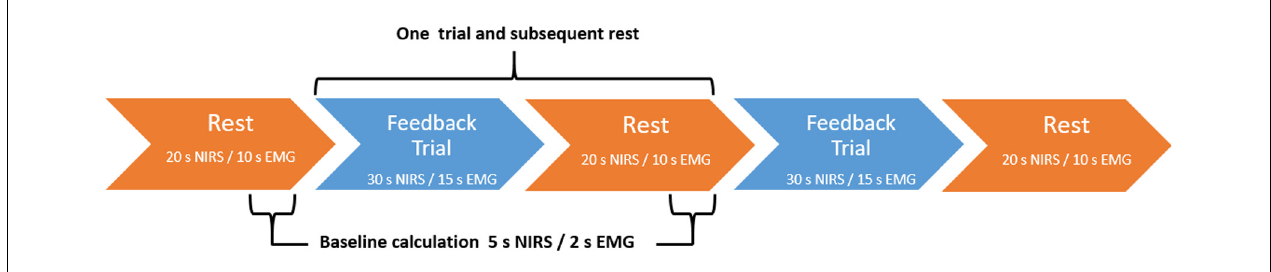
FIGURE 3 | Feedback block design. fNIRS-based NF blocks consisted of either 12 NF trials and subsequent rest trials (continuous feedback blocks one and three) or 8 NF trials and subsequent rests (transfer block two). EMG-based BF blocks consisted of either 24 BF trials and subsequent rests (continuous feedback blocks one and three) or 16 BF trials and subsequent rests (transfer block two). In both conditions, blocks always began with a rest trial.